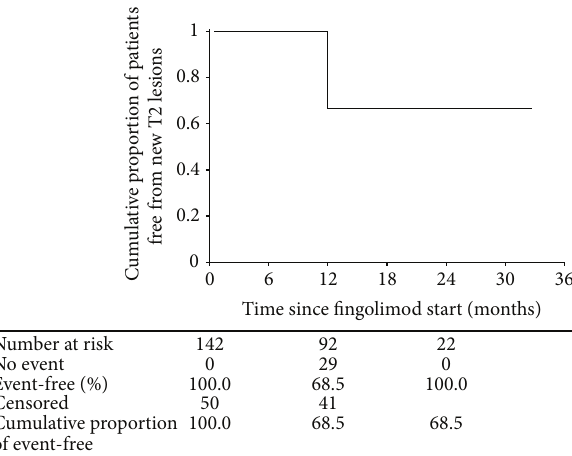
Figure 3: Kaplan-Meyer plot of cumulative proportion of patients remaining free from Expanded Disability Status Scale (EDSS) progression over time from start of fingolimod therapy.